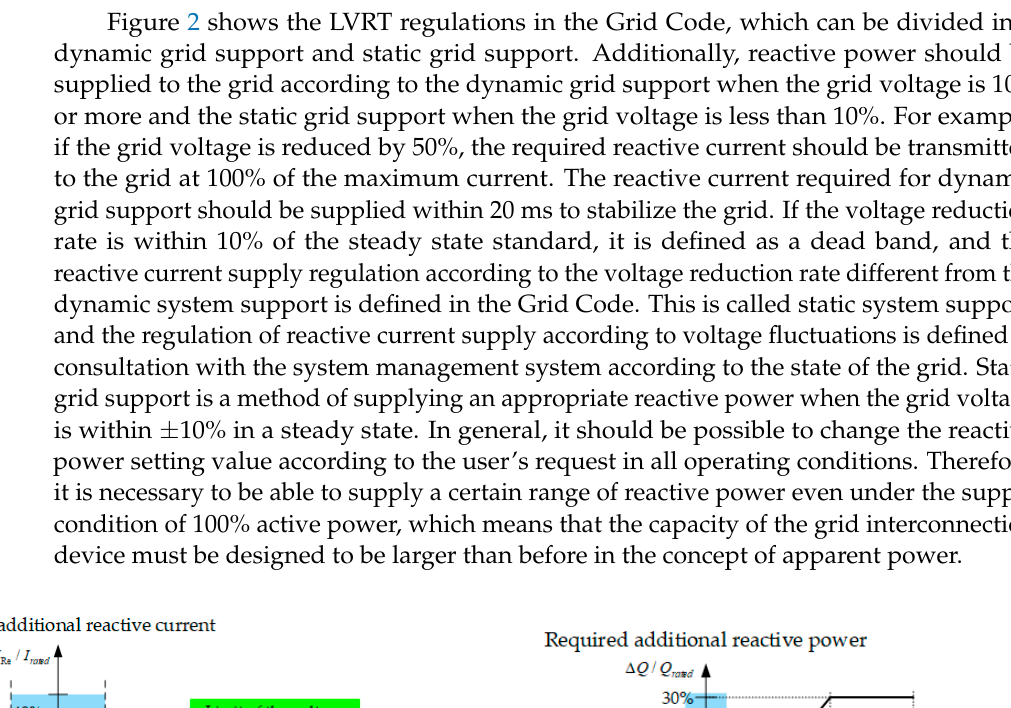
Figure 1. Requirements for FRT by German Grid Code.